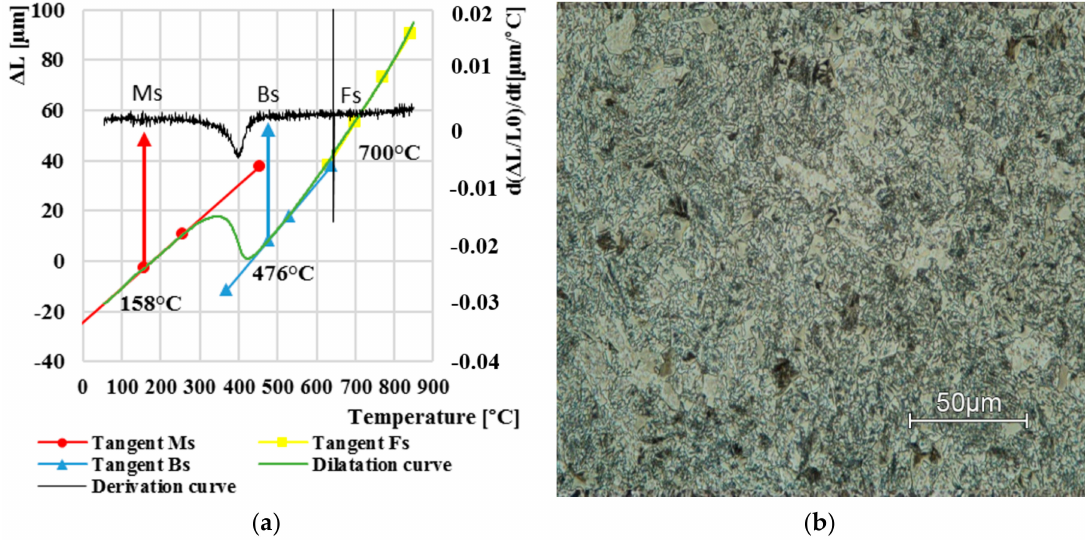
Figure 7. Dilatation curve ( a ); the final microstructure LOM ( b ) after cooling at 0.01 ◦ C · s − 1 . The average temperature of Ms was determined from the dilatation curves in which only the martensite structure was formed. We used the first five cooling curves from 100 The results are shown in Figure 8. By averaging these five temperatures from the individual curves, ◦ the average temperature Ms was of 282 C. We could not measure the temperature Mf on any curve, because the austenite to martensite transformation occurred below RT (room temperature). We can observe that as the cooling rate lowers, the temperature Ms also